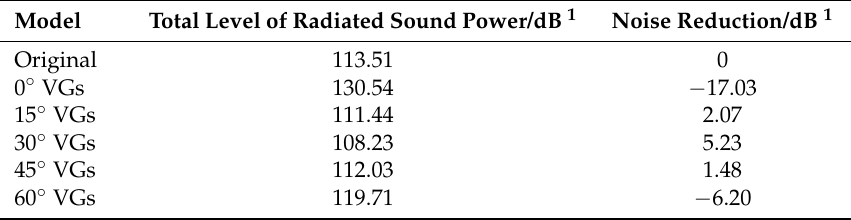
Table 2. The total level of radiated sound power from the original model and the models with triangular VGs at different